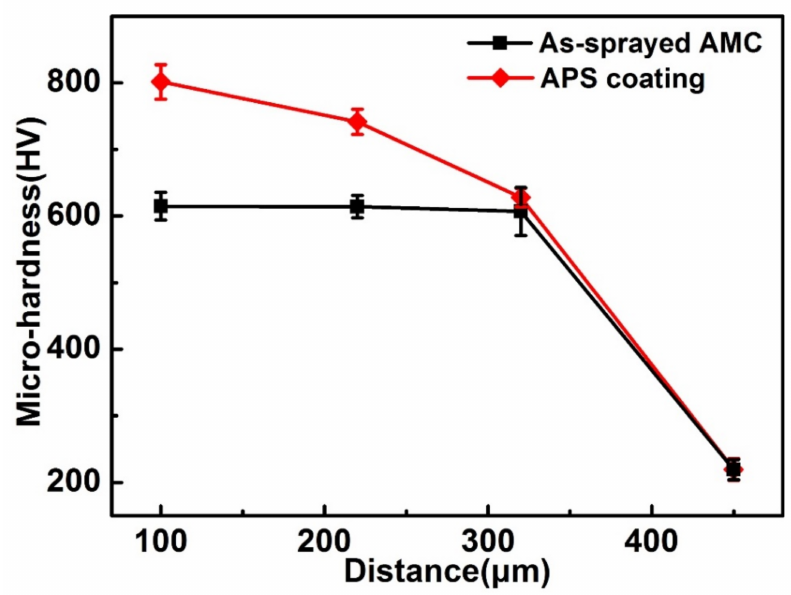
Figure 13. Micro-hardness of APS coating along the cross-section from the near-surface of this coating to the